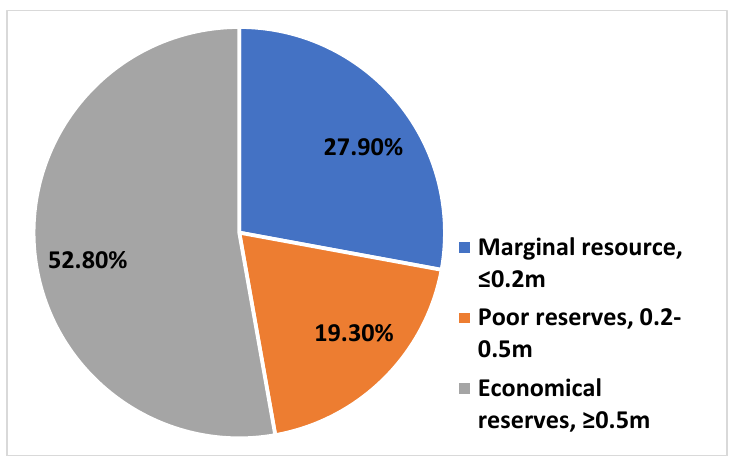
Figure 1. Geological resource distribution of the studied oilfield (data from [2]).